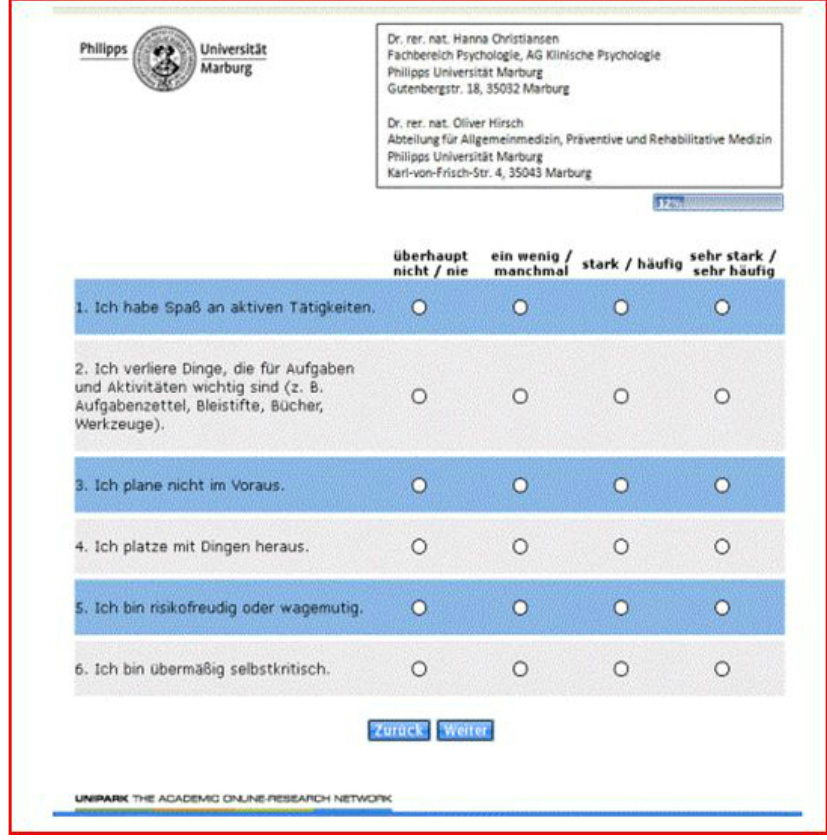
Figure 1. Example of survey items per